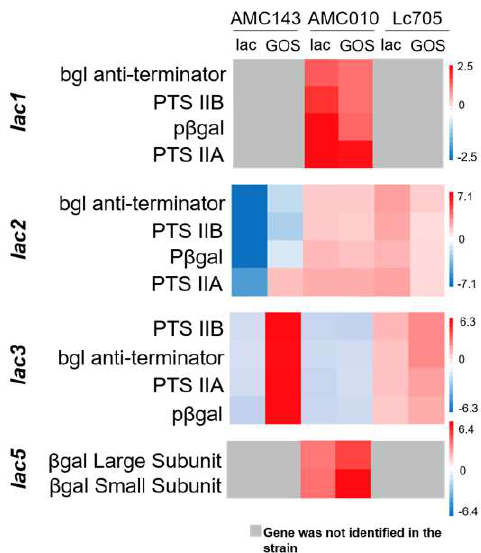
Figure 5. Expression of lac operons in GOS and lactose. Heat maps were generated from mRNA sequencing data for the identified lac operons in AMC143, AMC010, and Lc705, significantly differentially regulated by treatment with either GOS or lactose ( p < 0.05 after Bonferroni correction). The fold change for each gene was determined by comparing expression data from lactose or GOS versus glucose. Gray boxes represent genes not identified in the corresponding genome. PTS: Phosphotransferase System.